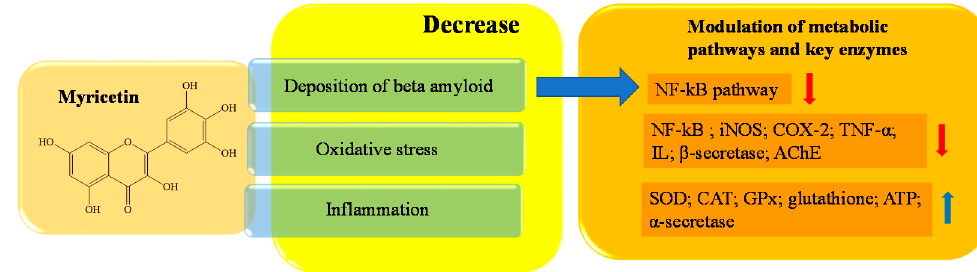
Figure 7. Schematic effects of myricetin on molecular targets of AD. Gossypetin (3,5,7,8,3 (cid:48) ,4 (cid:48) -hexahydroxy flavone) is a flavonol isolated from the